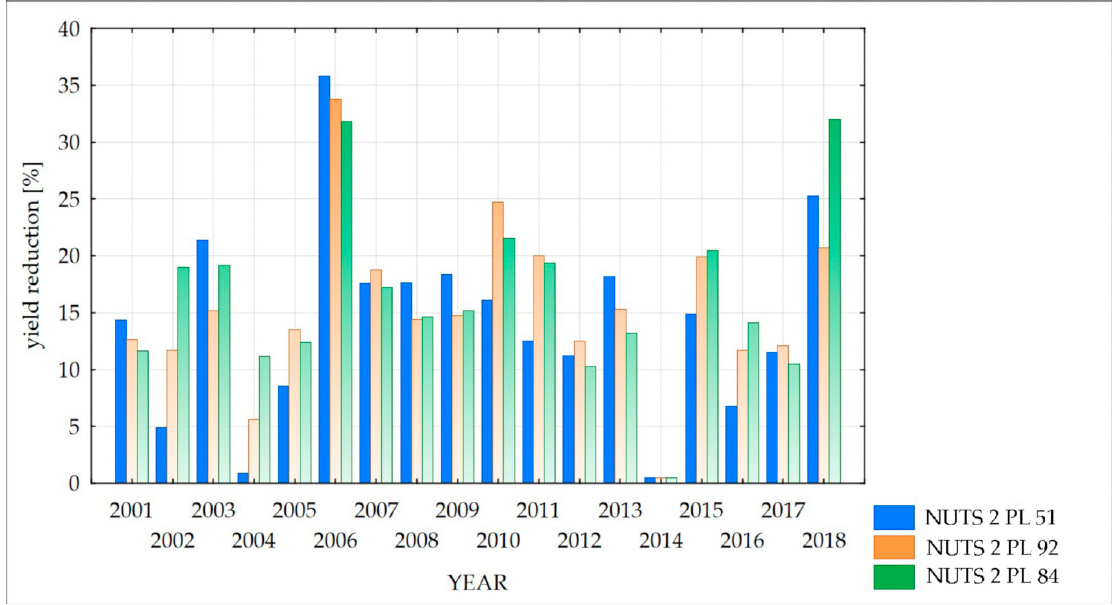
Figure 21. Cereal yield reduction for the selected NUTS 2 regions.